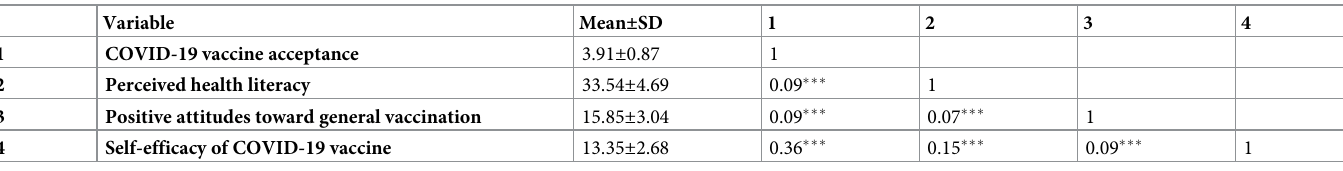
Table 2. Correlation matrix of measured variables.